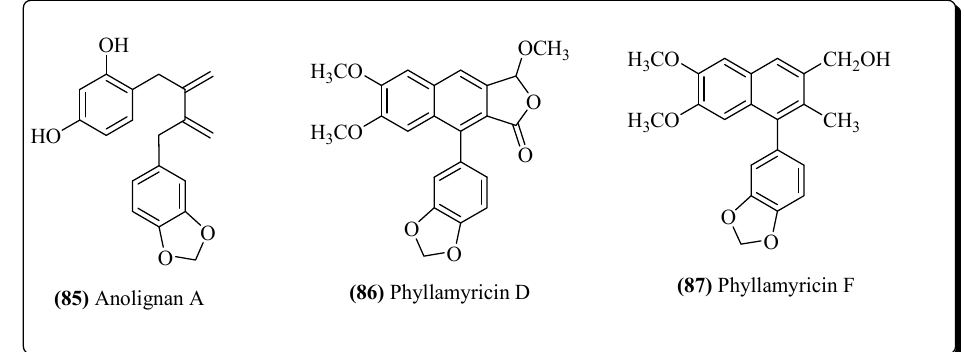
Figure 17. Lignans possessing anti-HIV activities.